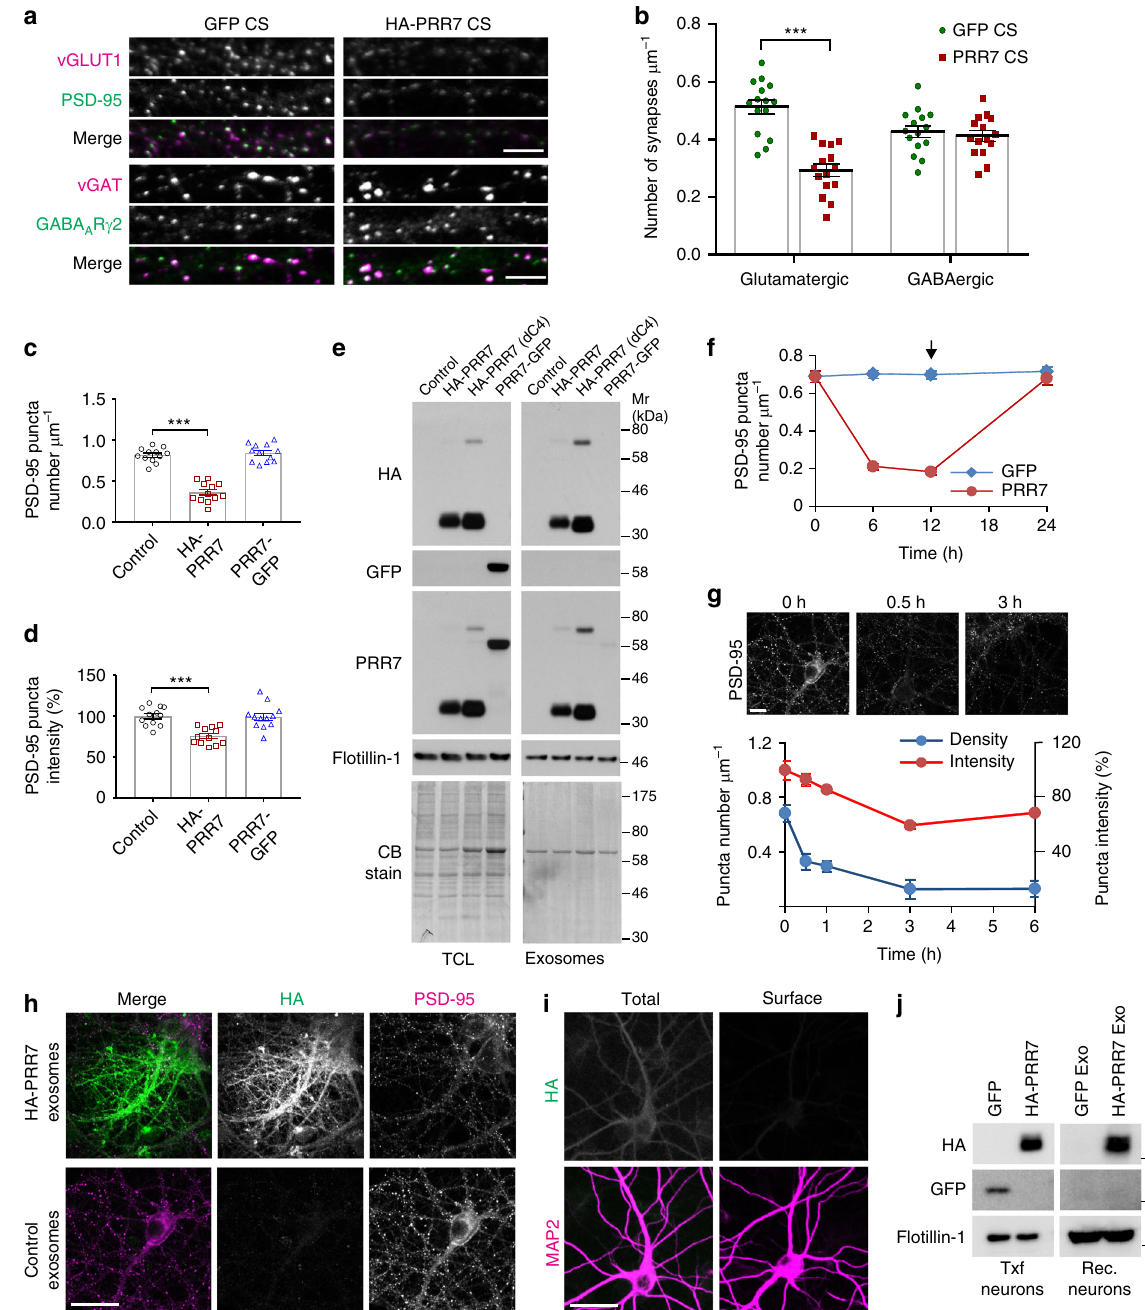
Fig. 5 Exosomal PRR7 is suf fi cient for the removal of excitatory synapses. a Representative immuno fl uorescent images of PSD-95/vGLUT and vGAT/ GABA A R γ 2 in hippocampal neurons treated with CS harvested from GFP control-transfected or HA-PRR7-transfected neurons. b Quantitation of the CS effect on excitatory and inhibitory synapses. c , d Quantitation of the CS effects on PSD-95 harvested from GFP-transfected, HA-PRR7-transfected or PRR7- GFP-transfected neurons. Cluster density ( c ) and intensity ( d ). n = 12 per condition. e Exosomal secretion of various PRR7 mutants. CB Coomassie blue staining. f Reversal of PSD-95 clusters by replacing PRR7-overexpressing CS with normal conditioned medium at 12 h. g Time course of the effect of HA- PRR7-exosomes on PSD-95. Top panels show representative images and quanti fi ed data are shown bottom. n = 15 each. h – j Uptake of exosomal PRR7 by neurons. Representative images of hippocampal neurons treated with exosomes puri fi ed from either GFP-transfected (control) or HA-PRR7-transfected neuron culture. Total staining of HA and PSD-95 in recipient neurons after the spot application of exosomes ( h ). Total and surface staining of HA and MAP2 after the application of evenly mixed HA-PRR7-containing exosomes ( i ). Western blotting analyses of TCLs prepared from Txf and exosome-treated recipient (Rec.) neurons ( j ). Scale bars, 5 ( a ), 10 ( g ), and 20 μ m ( h , i ). All data are mean ± SEM. Two-way ( b ) or one-way ANOVA ( c , d ) Post hoc Tukey ’ s test, F 1,56 = 30.71 ( b ), F 2,33 = 78.78 ( c ), and F 2,33 = 14.66 ( d ). *** P < 0.0001. Mr relative molecular